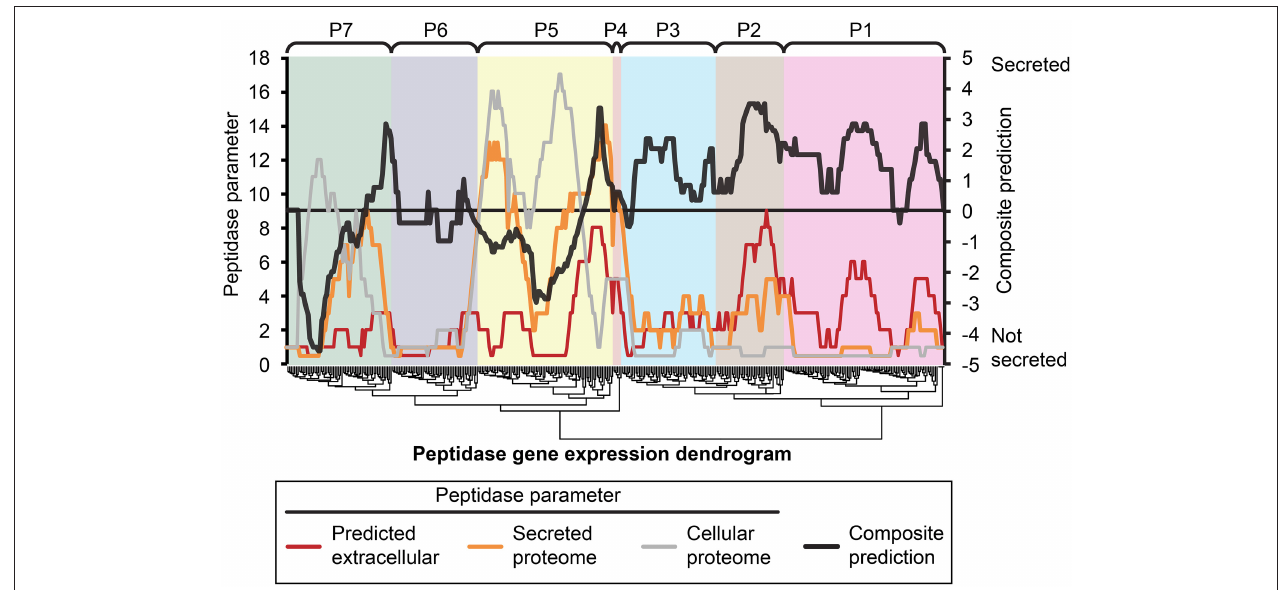
FIGURE 5 | Composite analysis of peptidase secretion and in planta expression. Peptidase secretion parameters were calculated for each peptidase shown in Figure 1 . Peptidases are ordered by their gene expression profile, as in Figure 1 . The peptidase frequency for three peptidase parameters, (1) bioinformatic prediction of secretion “Predicted extracellular,” (2) presence in the “Secreted proteome,” and (3) presence in the “Cellular proteome” was plotted on the leftmost Y-axis axis as a moving window (window size = 16), for example, if the value is 10, that means 10 out of 16 peptidases in the window were predicted to be secreted based on sequence characters. The right-most Y-axis shows the resultant “Composite prediction” of secretion (black trace), Composite prediction was calculated as Log 2 [mean[(1),(2)]/(3)], where a positive result indicates more likely secretion, a negative result less likely secretion. The gene expression clusters of peptidases determined in Figure 1 are shown above the plot.